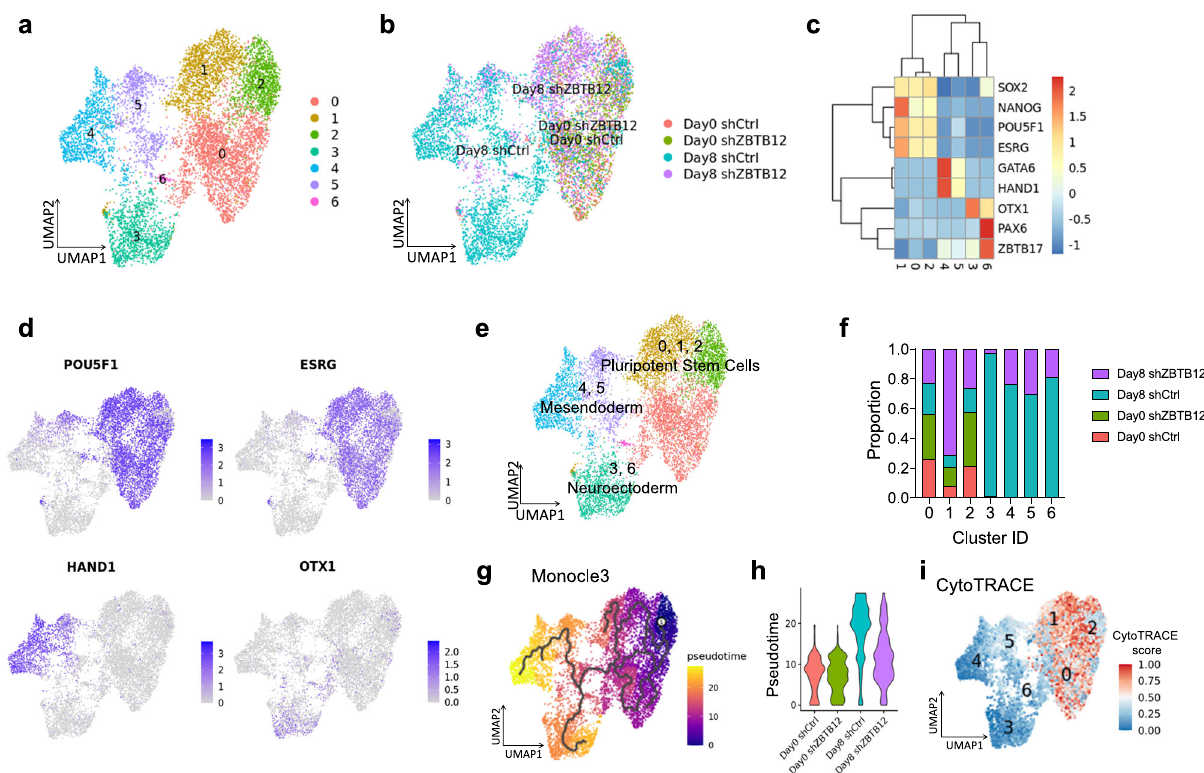
Fig.2|SinglecellRNAsequencingrevealsthenecessityofZBTB12forexitfrom pluripotency. a , b UMAP plots of 8,618 cells after QC (Supplementary Fig. 3a – f), normalization, dimensionality reduction and clustering, colored by cluster iden- tities ( a ) or by experimental groups ( b ). c Heatmap of representative marker gene expression of pluripotency (SOX2, NANOG, POU5F1 and ESRG), mesendoderm (GATA6 and HAND1) and neuroectoderm (OTX1, PAX6, and ZBTB17). d Feature plots of gene expression associated with pluripotency (POU5F1 and ESRG),